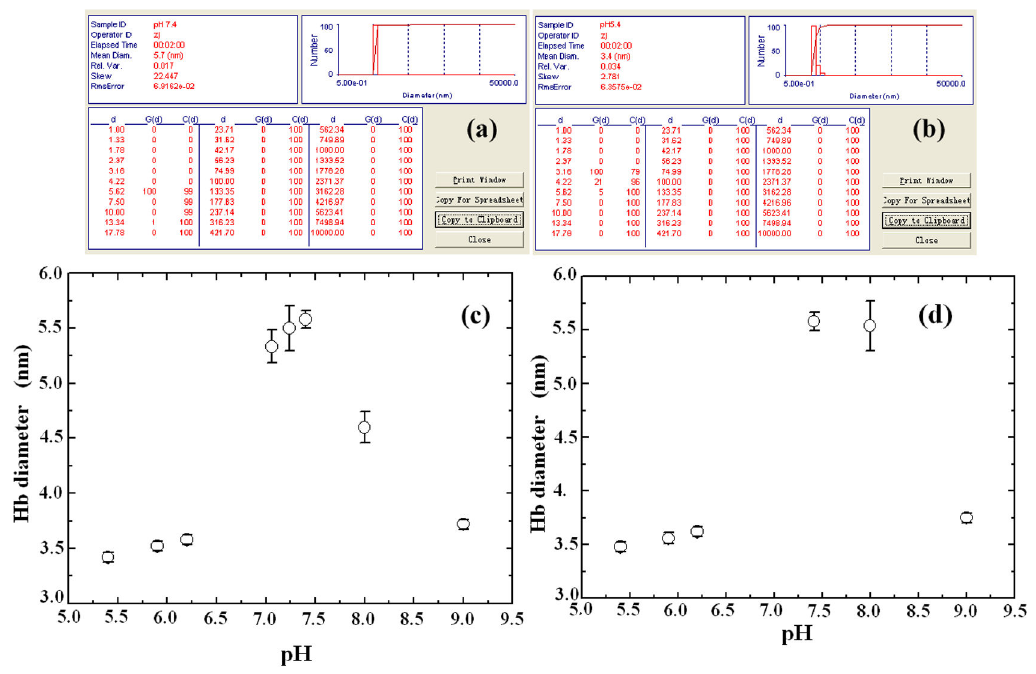
Figure 1. The hydrodynamic diameters and size distributions of human hemoglobin in solutions with different pH levels. (a) The size distribution of Hb at pH 7.4; (b) the size distribution of Hb at pH 5.4; (c) the averaged diameters of human hemoglobin vs. pH level; (d) the averaged hemoglobin diameters in the solutions after their pH levels had been returned to normal condition. The pH values indicated in the horizontal coordinate are the original pH values of the sample